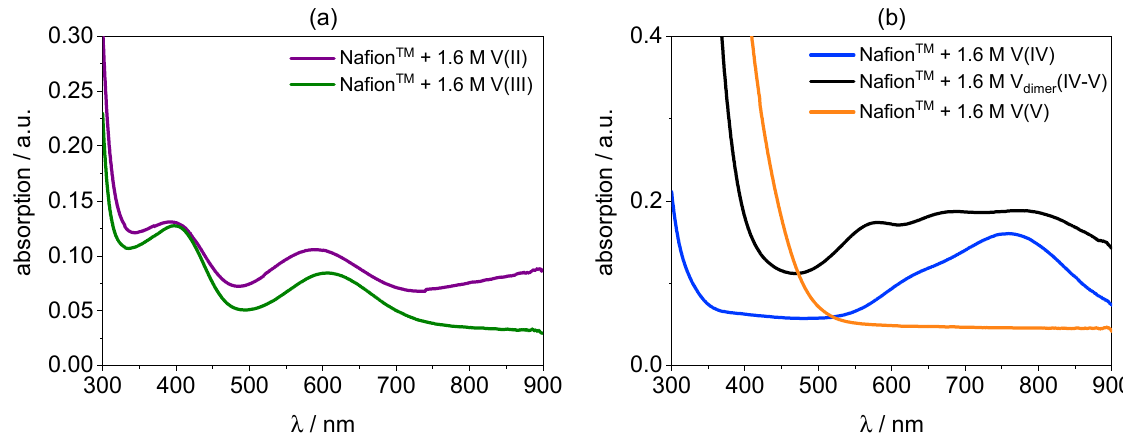
Figure 9. ( a ): UV/VIS spectra of Nafion™ hydrated with V(II) and V(III). ( b ): UV/VIS spectra of Nafion™ hydrated with V(IV), V dimer (IV–V), and V(V). The spectrum of V(II) in the membrane shows strong absorption peaks at 400 nm and 590 nm. Additionally, a weak peak at 890 nm is present. The spectrum of V(III) in Nafion™ shows strong peaks at 400 nm and 610 nm. The V(IV) species in the membrane absorbs strongly at 765 nm and at lower wavelengths from 330 nm increasing toward lower wavelength. The spectrum of V(V) is quite plain. It shows just an increase toward lower wavelengths at 520 nm. In Figure 10, the UV/VIS spectra of V dimer (IV–V) in Nafion™ and in electrolyte are shown. It is obvious that the spectra are mostly identical, besides the overall intensity of the absorption.